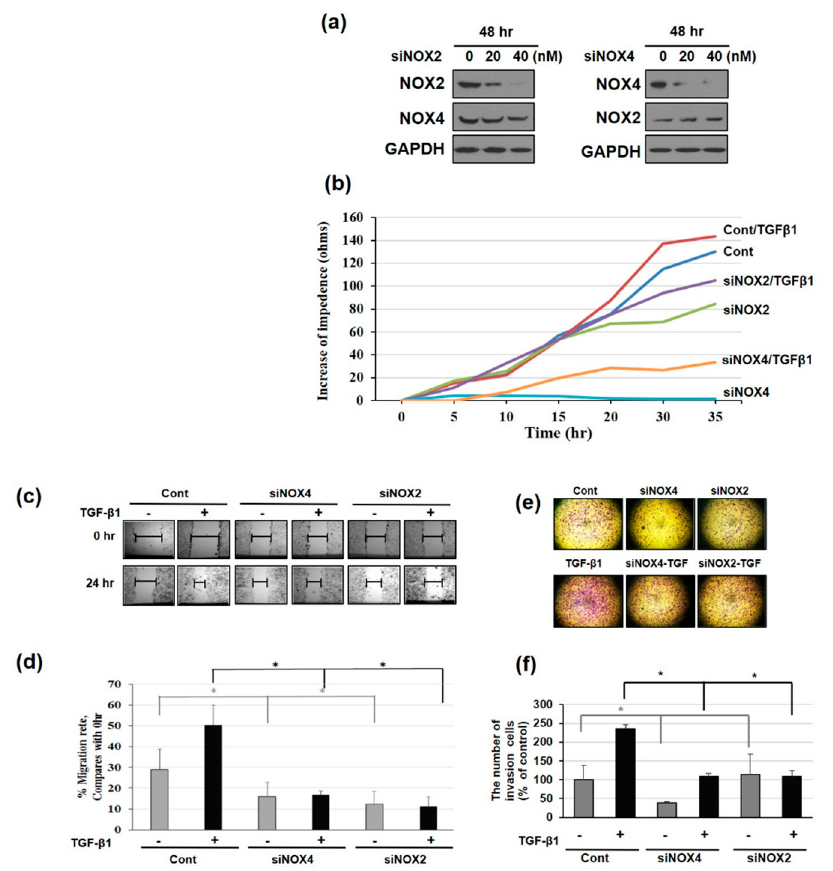
Figure 4. Effect of NOX2 or NOX4 knockdown on the proliferation, migration, and invasion of HeLa cells. ( a ) Representative Western blot of NOX2 and NOX4 protein expression in HeLa cells treated with siRNA-NOX2 or siRNA-NOX4 (at a final concentration of 20 or 40 nM) for 48 h. HeLa cells were transfected with NOX2 siRNA or NOX4 siRNA. After 24 h, cells were seeded over the electrode wells ( b ), six-well plate ( c ), and transwell plates ( d ). ( b ) HeLa cell growth curve in the presence of NOX2 or NOX4. NOX2 or NOX4 knockdown effect was assessed by measuring the change in HeLa cell growth responses using TGF- β 1-treated cells by ECIS analysis over 35 h. ( c , d ) Inhibition of cell migration by NOX2 or NOX4 siRNA. ( c ) TGF- β 1-induced cell migration was blocked by NOX2 or NOX4 siRNA. Cells were wounded by scratching the monolayer with a 200- µ L sterile tip. The scratched monolayers were rinsed with PBS buffer and exposed to TGF- β 1 for 24 h. ( d ) Quantitative analysis of the migration speed of cells. The distance traveled by the cell front was divided by the time-period to obtain the migration speed. After 24 h, the wound gaps were photographed using an inverted microscope and quantified by ImageJ software. Results shown are Control vs. NOX2-or NOX4-knockdown cells; * p < 0.0001, ** p < 0.00001, n = 10. Data are summarized as the means ± standard deviation of three separate experiments. *** p < 0.001 vs. control. ( e ) Invasive capacity of HeLa cells treated with NOX2 or NOX4 siRNA assessed using a Matrigel-coated transwell chamber. Transwell migration assay for negative control, TGF- β 1-treated, and siRNA groups (magnification, × 400). The values represent the means ± SD; n = 3 based on microscopic fields. * p < 0.05.